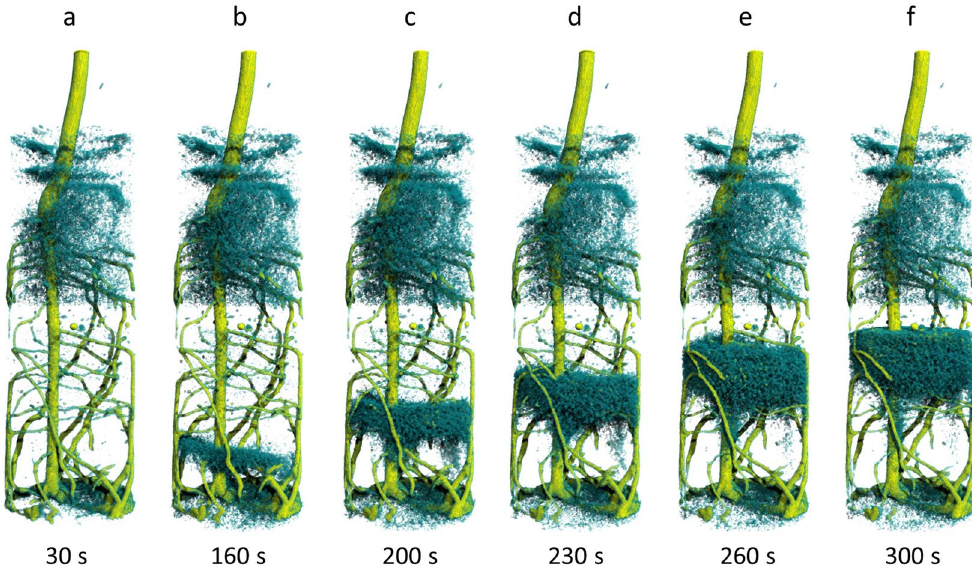
Figure 4. Time-resolved neutron tomography of the lupine root system after the injection of 4 ml deuterated water (D 2 O) through the bottom. The time series (30 s ≤ t ≤ 300 s) shows the ascending front of water (H 2 O) displaced by deuterated water moving upwards. The time resolution for each tomogram is just 10 s. A video of this sequence is provided in the supplementary